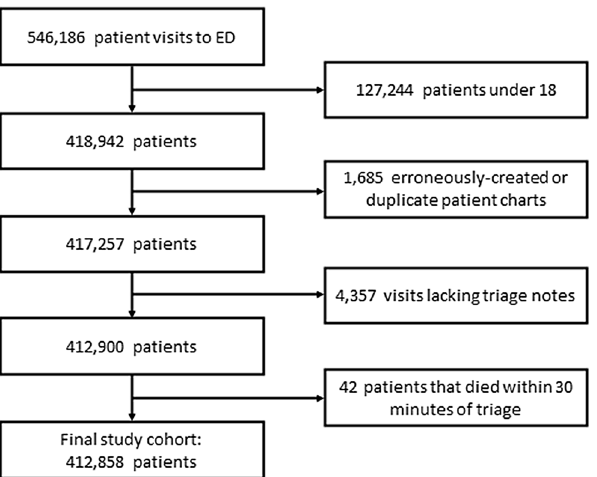
Figure 2. Study inclusion flowchart. ED emergency department, NSICU neuroscience intensive care